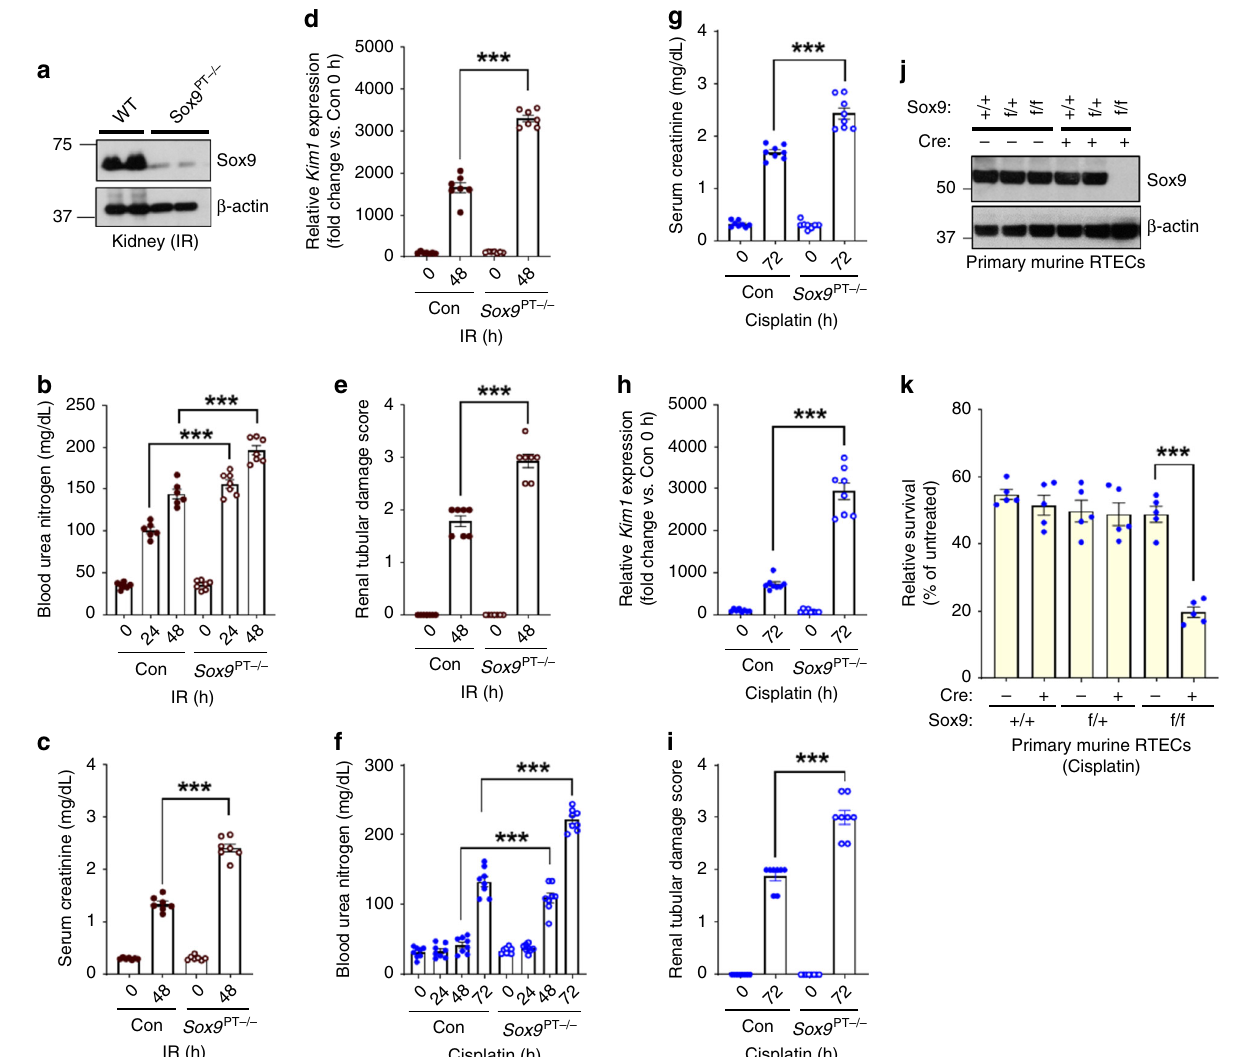
Fig. 5 SOX9 plays a protective role during AKI. To generate mice with renal tubule-speci fi c Sox9 knockout, Ggt1-Cre mice were crossed with Sox9- fl oxed mice. a Representative western blots showing successful knockout in the renal tissues. Littermate control and Sox9 conditional knockout mice (indicated by Sox9 PT − / − ) were used to study the role of SOX9 in AKI. Bilateral renal ischemia was induced in wild-type and Sox9 PT − / − mice for 30 min followed by examination of renal structure and function. b Blood urea nitrogen, c serum creatinine, d renal Kim1 mRNA expression, and e renal histological analysis (H&E) showed that tubular epithelial-speci fi c Sox9 de fi ciency exacerbates ischemia-associated AKI. Data presented ( b – e ) are cumulative of three independent experiments ( n = 6 – 7). Wild-type and Sox9 PT − / − mice were treated with cisplatin (30 mg/kg) followed by examination of renal function. f Blood urea nitrogen, g serum creatinine, h renal Kim1 mRNA expression, i and renal histological analysis (H&E) showed that SOX9 regulates cisplatin- mediated AKI. Data presented ( f – i ) are cumulative of two out of four independent experiments ( n = 8) that showed similar results. j Primary renal tubular cells were cultured from wild-type and Sox9 - fl oxed mice. One week later, lentiviral transductions (Cre) were carried out to delete Sox9 gene. Western blot analysis con fi rmed SOX9 deletion. Blots are representative of two independent experiments. k Primary renal tubular cells with indicated genotype were treated with 50 µ M cisplatin, followed by cell viability assessment using trypan blue staining. Data are presented as individual data points ( n = 4 biologically independent samples), from one out of three independent experiments, all producing similar results. In all the bar graphs, experimental values are presented as mean ± s.e.m. The height of error bar = 1 s.e. and p < 0.05 was indicated as statistically signi fi cant. One-way ANOVA followed by Tukey ’ s multiple-comparison test was carried out, and statistical signi fi cance is indicated by * p < 0.05, ** p < 0.01, *** p < 0.001. Source data are provided as a Source Data fi (Supplementary Fig. 13b – e). For further con fi rmation, gene increased, while Gadd45a gene expression was reduced (Supple- expression analysis was carried out, which showed that as mentary Fig. 15). Luciferase-based reporter assays con fi rmed compared with the littermate controls, renal tissues of Sox9 PT − / − Sox9 binding within the promoter regions of Wwp2 , Myof , and mice have diminished mRNA expression of Wwp2 , Myof , and Sema3e genes (Supplementary Fig. 16). Finally, functional studies Sema3e , while Gadd45a expression is elevated (Supplementary show that Wwp2, Myof, and Sema3e knockdown sensitizes Fig. 14). In the Cdkl5 PT − /y mice, which had elevated levels of RTECs to injury, while Gadd45a knockdown provides protection Sox9 protein during AKI, the mRNA levels of Sox9-dependent from cell death (Supplementary Fig. 17). Thus, by increasing the pro-survival genes ( Wwp2, Myof, and Sema3e ) were signi fi cantly expression of pro-survival genes like Wwp2 , myof , and sema3e ,